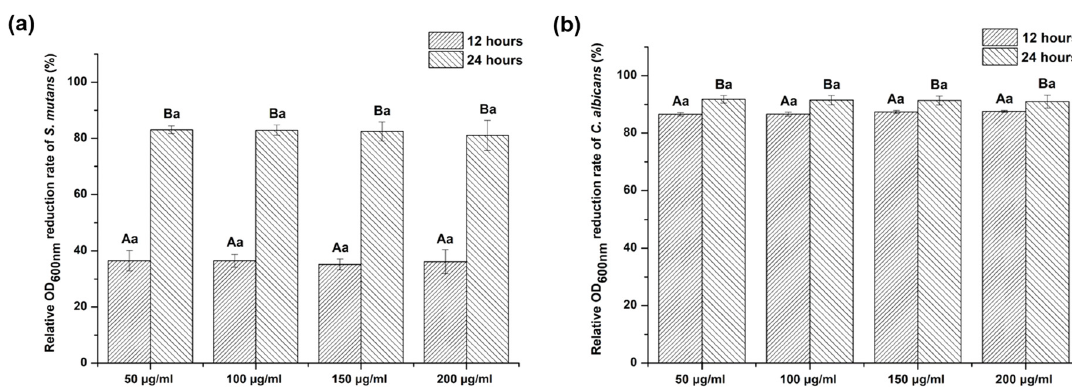
Figure 3. Relative optical density (OD 600nm ) value reduction rate of ( a ) Streptococcus mutans and ( b ) Candida albicans exposed to Glycyrrhiza uralensis extract with concentrations of 50, 100, 150, and 200 µg/mL at two different times. The same lowercase letters show no significant difference in relative OD 600nm reduction rate between the experimental groups at each time point ( p > 0.05). The different uppercase letters indicate significant differences in relative OD 600nm reduction rate between 12 and 24 h for each experimental group ( p < 0.05).